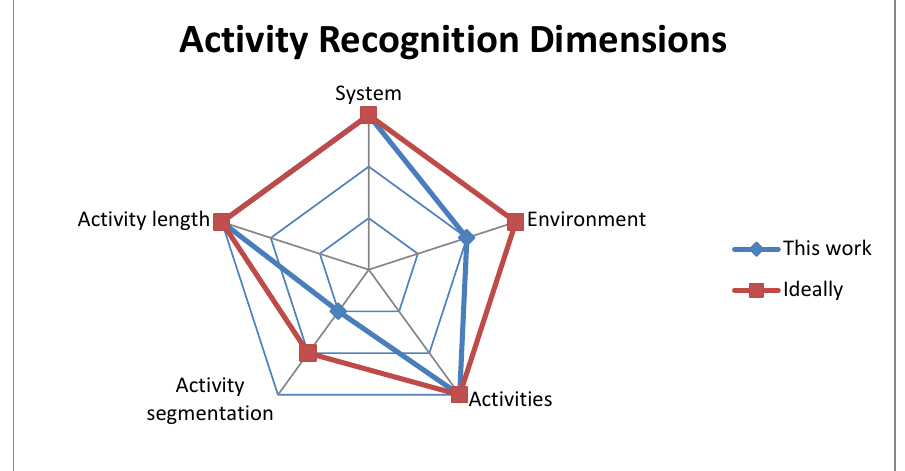
Figure 1. Activity recognition dimensions. “This work” designates the space that this paper is addressing, while “Ideally” designates the ideal space to be